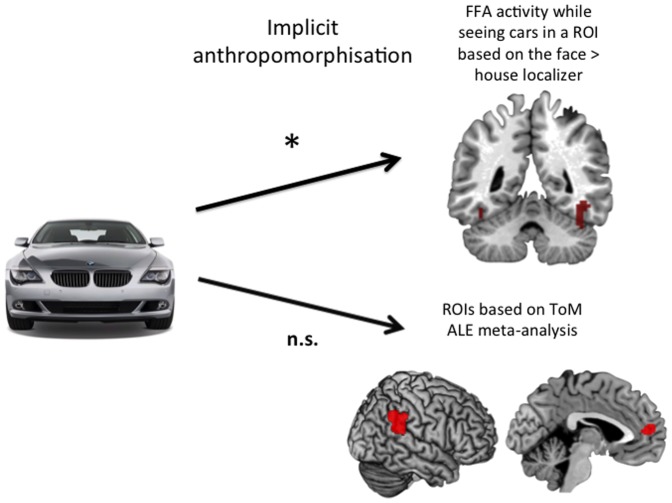
Schematic illustration of the results of the linear mixed model, where prediction of bilateral fusiform face area (FFA) activation benefits from the inclusion of the individual's degree of anthropomorphism of the specific car, whereas the prediction of temporoparietal junction (TPJ) and medial prefrontal cortex (MPFC) does not seem to be associated to the tendency to anthropomorphize.